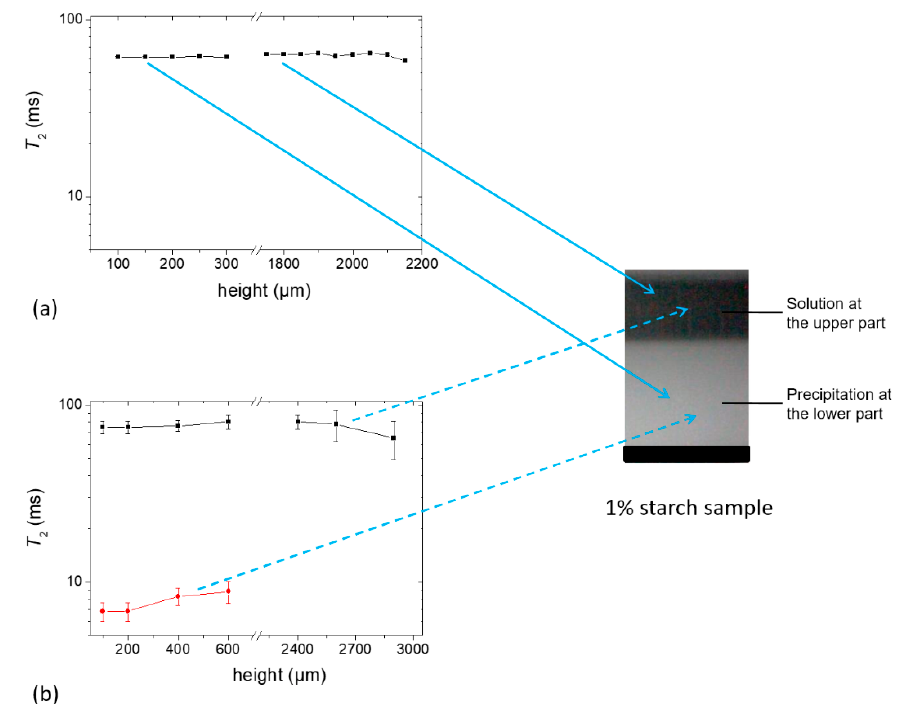
Figure 7. T 2 constants at di ff erent heights of ( a ) Sample e containing 1% starch in H 2 O ( w / v ) (echo decay was collected using 32 scans) and ( b ) Sample f containing 1% starch in D 2 O ( w / v ) (echo decay was collected using 2048 scans). Glycerol (20 g / 100 g of starch) was used as a plasticizer.